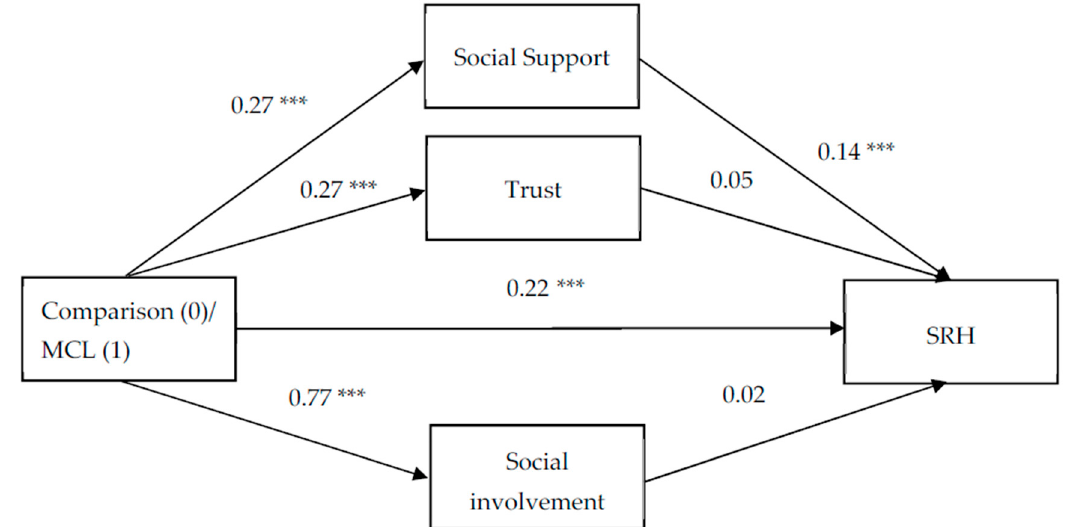
Figure 2. The mediation effect of social capital components on the link between participation in the Mamanet Cachibol League and self-reported health (SRH) (unstandardized coefficients). *** p < 0.001.